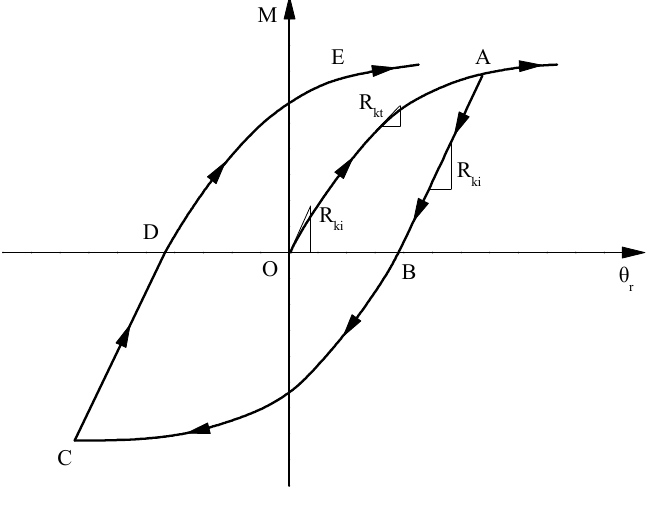
Figure 4. Independent hardening model.